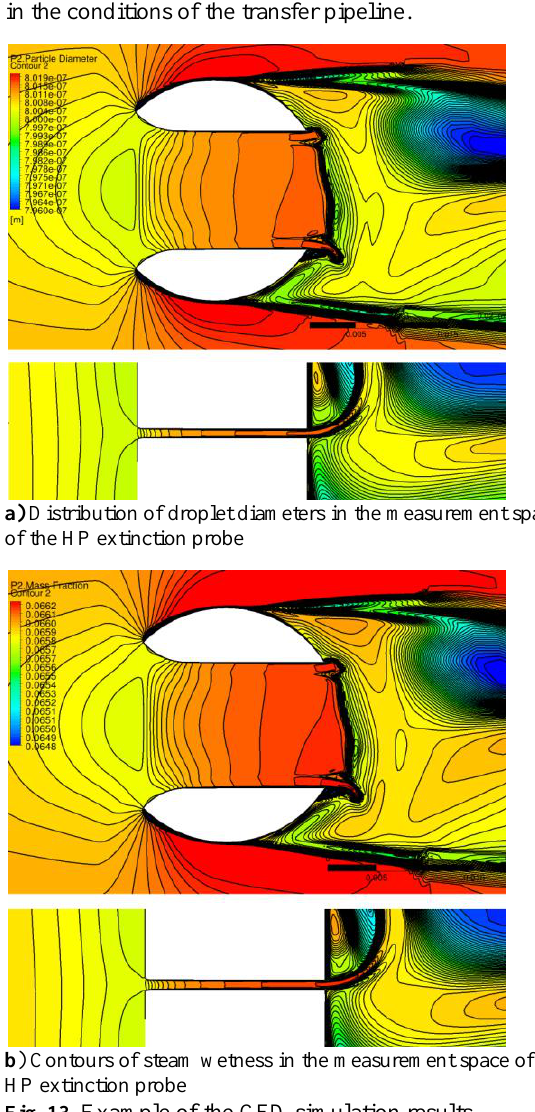
Fig. 13. Example of the CFD simulation